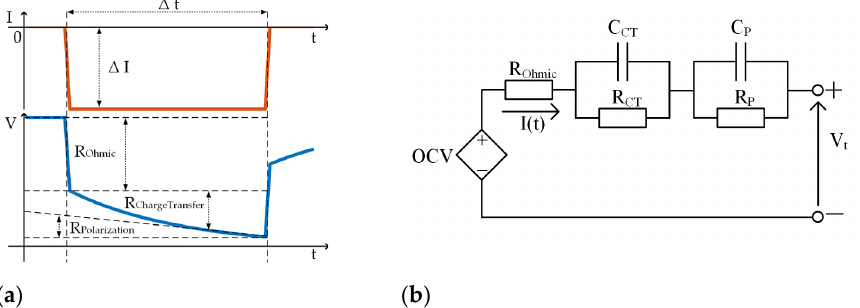
Figure 6. ( a ) Schematic illustration of a squared current pulse and indicated contributions of various resistance parts. ( b ) Equivalent electrical circuit model that can be used via parameter identification for a general quantification of the resistances.